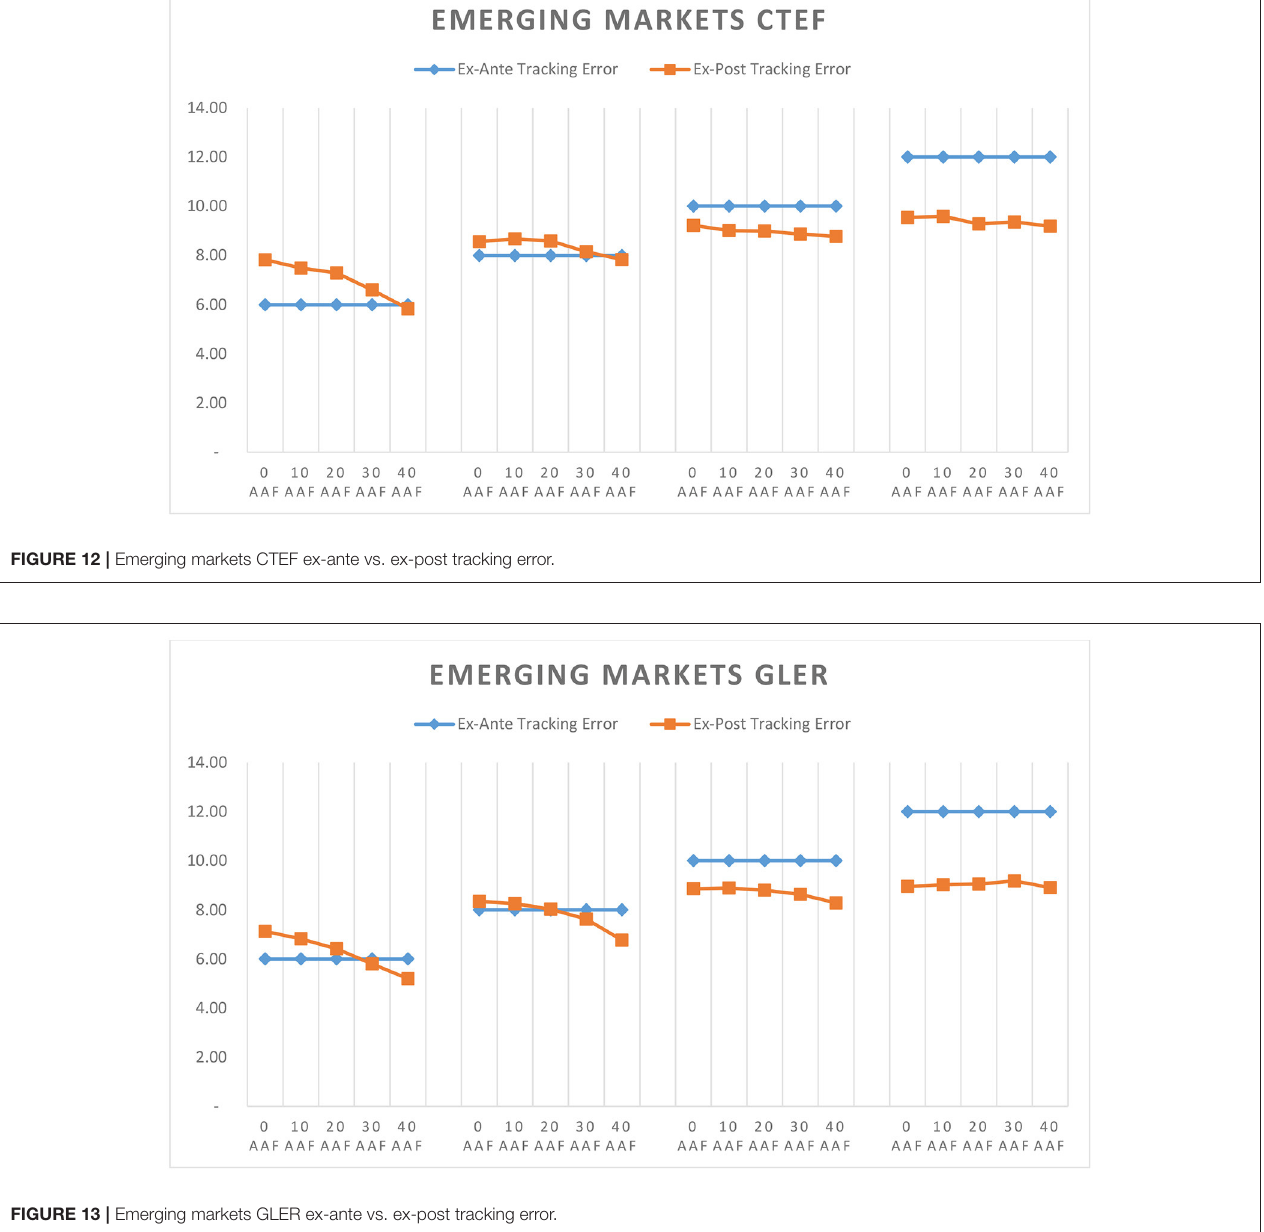
FIGURE 13 | Emerging markets GLER ex-ante vs. ex-post tracking